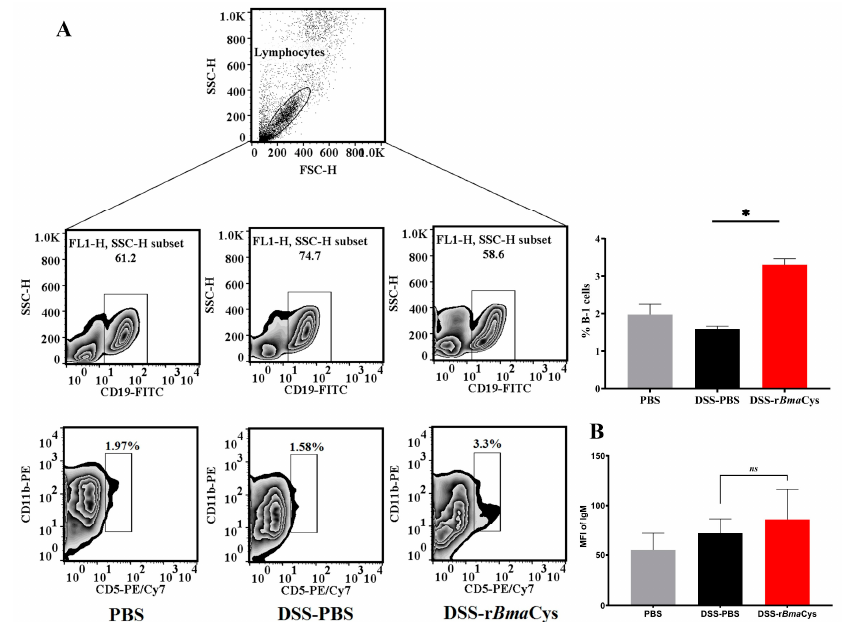
Figure 6. Frequencies of IgM + peritoneal B1a cells. Peritoneal cells from each group of mice were plated for 24 h at 37 ◦ C. Following incubation, the non-adherent cell population was collected, gated for CD19, and the percent of CD11b + CD5 + cells within the CD19 + population was identified as B1a cells. In addition, we also determined the MFI of IgM (using anti-IgM antibodies) in the B1a cells. Our results show that there was a significant increase in the percentage of B1a cells in the DSS-r Bma Cys-treated mice ( A ). Our analyses also showed an increase in the frequency of IgM producing B1a cells in the DSS-r Bma Cys-treated mice but was not significant compared to the DSS-PBS mice ( B ). Each bar represents mean ± S.D. * P = 0.006 compared to DSS-PBS group determined using one-way ANOVA followed by Tuckey’s posthoc test, n = 10 mice per group, except the DSS-PBS group, which had 8 mice. ns = not